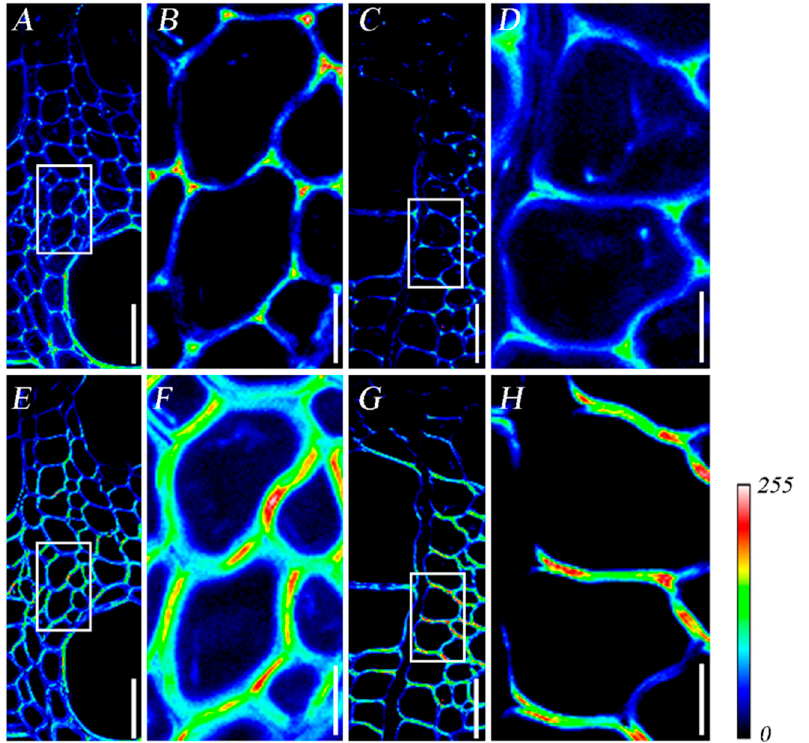
Figure 2. SRS chemical images of lignin and cellulose in developing xylem of P. euramericana ‘Neva’ and P. euramericana ‘Zhonglin46’. ( A , C ) SRS images of the developing xylem based on the deconvo- luted lignin band at 1600 cm − 1 in Neva ( A ) and Zhonglin46 ( C ). ( E , G ) SRS images of the developing xylem based on the cellulose band at 1100 cm − 1 in Neva ( E ) and Zhonglin46 ( G ). ( B , D , F , H ) Magnifi- cations of the white boxes in ( A , C , E , G) . Scale bar = 50 µm ( A , C , E , G ). Scale bar = 10 µm ( B , D , F , H ).